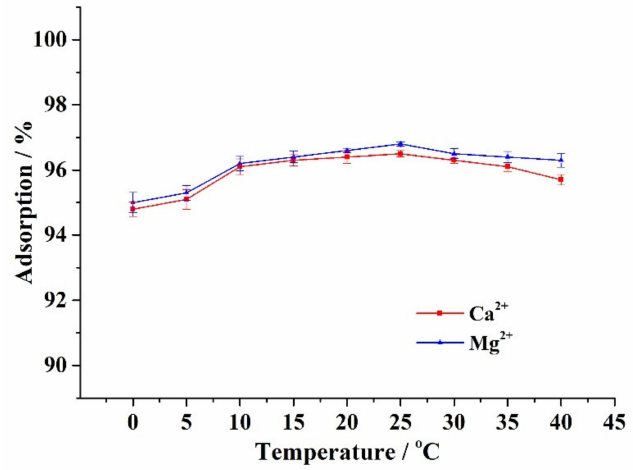
Figure 6. Influence of ambient temperature on the adsorption performance of CA–SC for Ca 2+ and Mg 2+ .